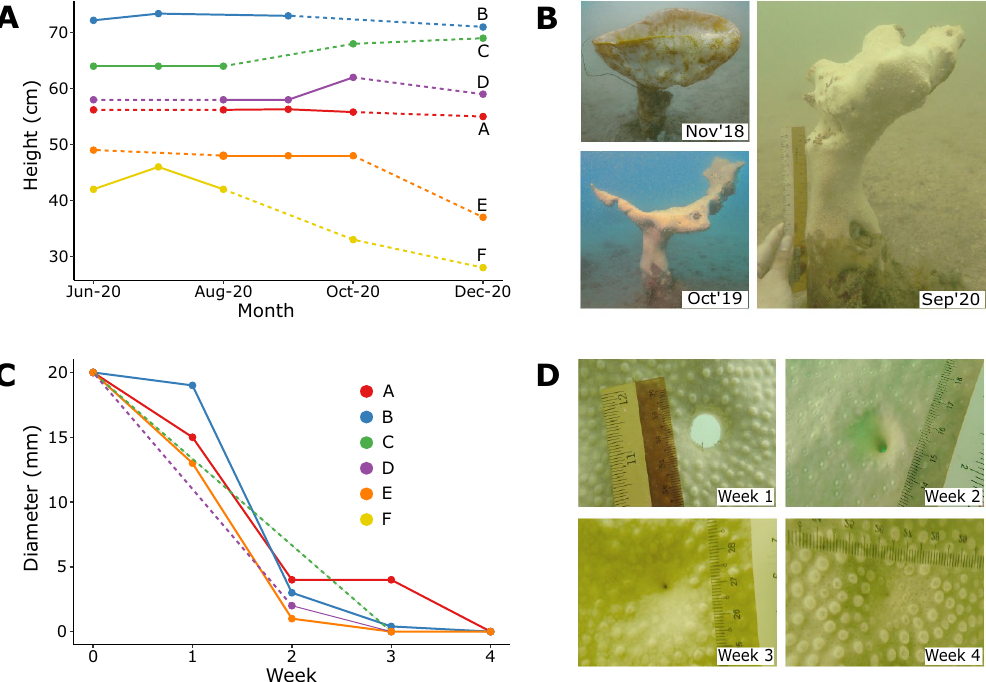
Figure 5. ( A ) Changes in height of Cliona patera sponges A–F over six months; ( B ) images showing changes to sponge F; ( C ) changes in diameter of 20 mm bored hole in sponges A–E over four weeks; sponge F was